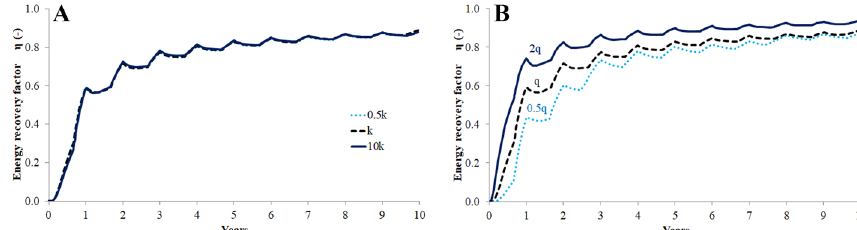
Fig. 20 Energy recovery factor for different intrinsic permeabilities (0.5 k, k and 10 k) of the aquifer ( A ) and different injection flow rates (0.5q, q and 2q) ( B )